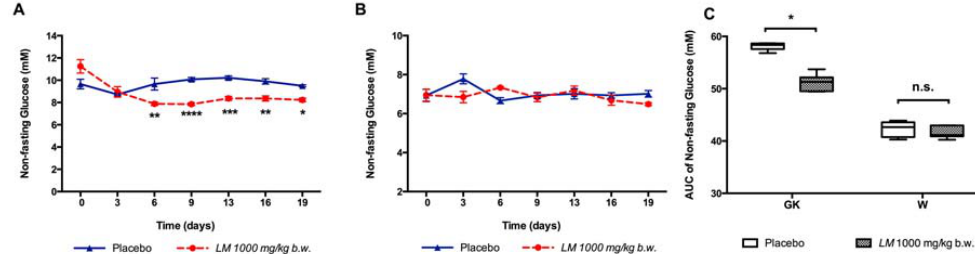
Figure 6. LM long ‐ term treatment reduces the non ‐ fasting glucose. The non ‐ fasting glucose was Figure 6. LM long-term treatment reduces the non-fasting glucose. The non-fasting glucose determined every third day in GK rats ( A ) and in W rats ( B ). The AUC for each group was calculated from day 0 to day 19 ( C ). Data are presented as means ± standard error of the mean SEM ( n = 6). * p < 0.05, ** p < 0.01, *** p < 0.001, **** p < 0.0001 when compared to Placebo. Plasma HbA1c levels were reduced by treatment with LM both in GK rats (5.9 ± 0.3%) at day 20